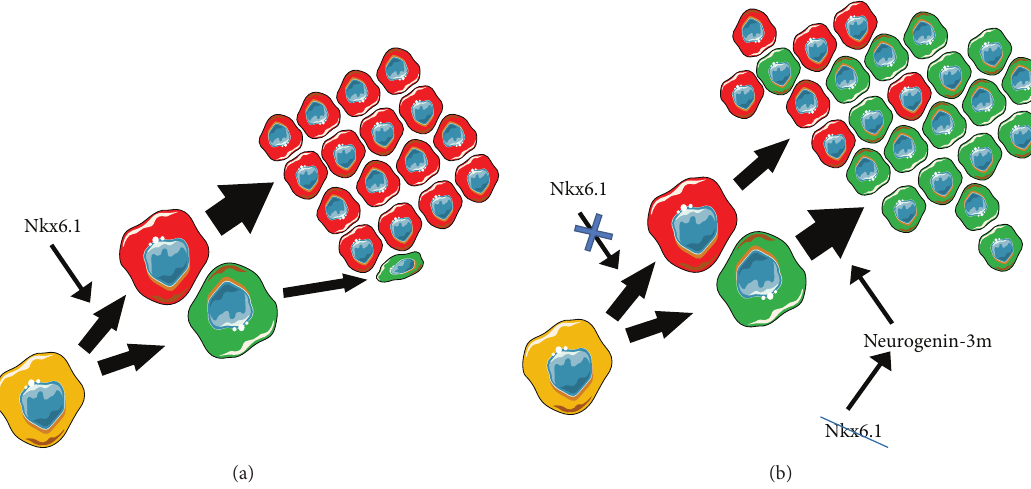
Figure 11: Hypothetical origin of delta cell hyperplasia. Schema was composed on the basis of [12, 13, 29] (see Section 4). (a) In nondiabetic animals, such as Wistar rats, SST-containing delta cells terminate proliferation after splitting from a common beta/delta cell progenitor while insulin-positive beta cells proliferate. (b) On the contrary, in diabetic Goto-Kakizaki rats, delta cells proliferation is not terminated, thus forming masses of SST positivity by the beta cell core mass. Origin of clonal proliferation of cells after splitting from the beta/delta cell progenitor can result from the known decreasing beta cell mass in Goto-Kakizaki PI, logically accompanied by the decrease of the beta cell- specifying factor Nkx6.1. A reduction of Nkx6.1 has been reported to increase neurogenin-3m, which in the absence of other factors promotes delta cells [29]. Common beta/delta progenitor cell: yellow, beta cells: red, and delta cells: green. The scheme was composed using Servier Powerpoint Image Bank: